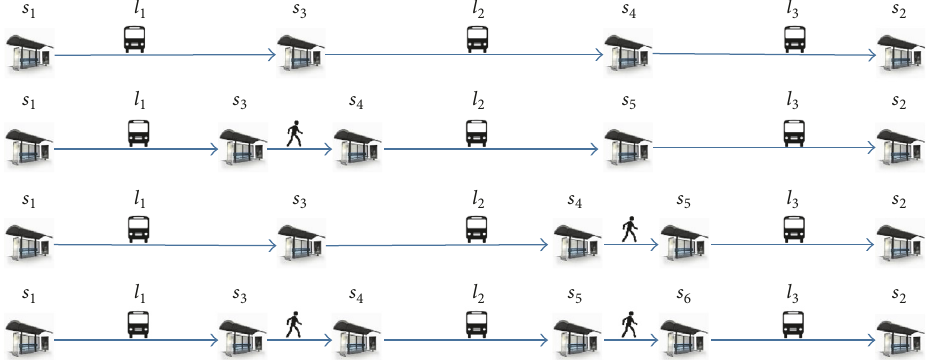
Figure 5: Illustration of routes with two